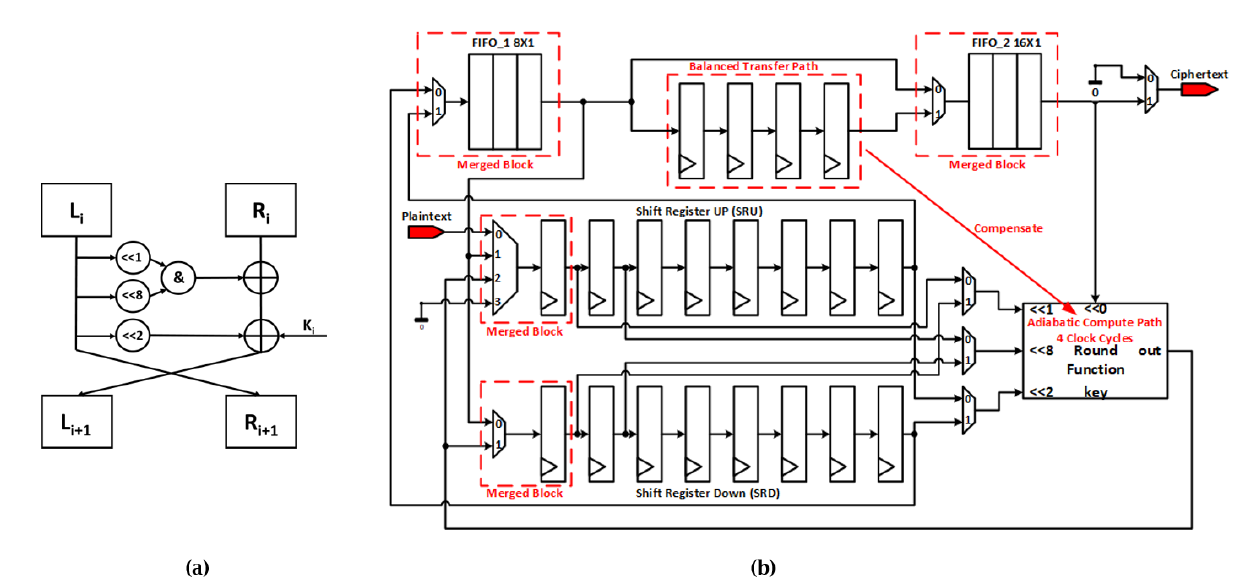
Figure 2. SIMON32/64 round function: ( a ) block-level diagram of the algorithm, ( b ) implementation of the round function in the adiabatic SIMON architecture, illustrating the merged blocks and balanced transfer